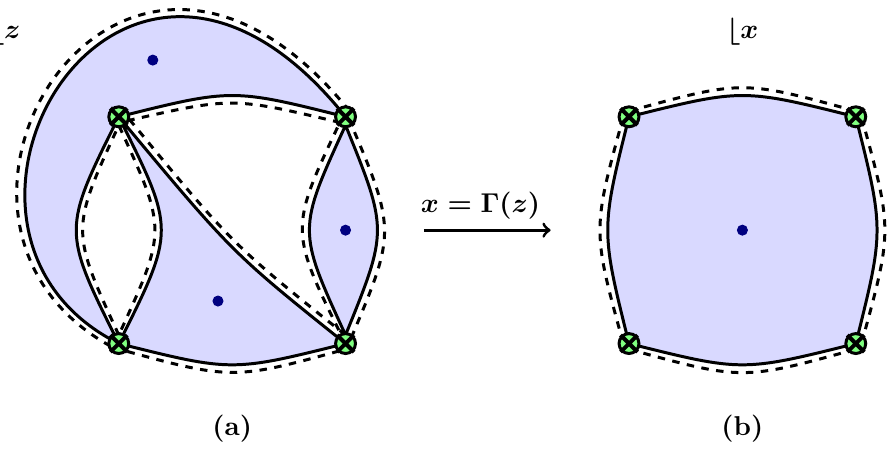
Figure 2 . An illustration of the Feynman graph of a symmetric orbifold correlator, constructed via the preimage of a Jordan curve under Γ . The case with n = 4 and all w which N = 3